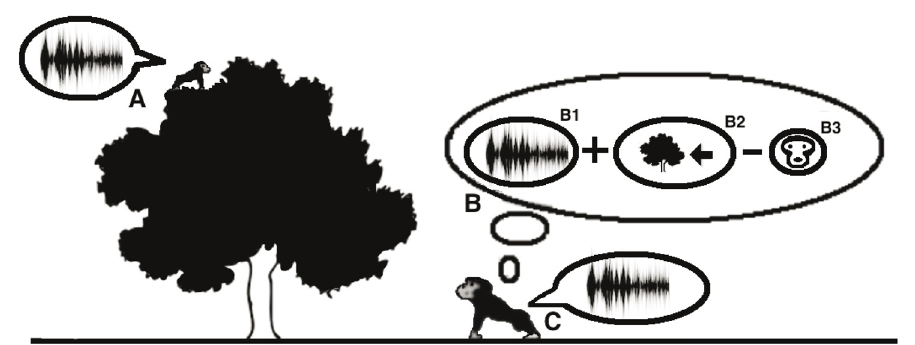
Figure 2. Discrete stages in contact call exchange. In accordance with the model, the original function of the ADS is for the localization of and the response to contact calls that are exchanged between mothers and their infants. When an infant emits a contact call ( A ), the mother identifies her offspring’s voice (B1) localizes the call (B2) and maintains this information in visual working memory. Then, if the corresponding face is absent in that location (B3), the mother emits a contact call in return ( C